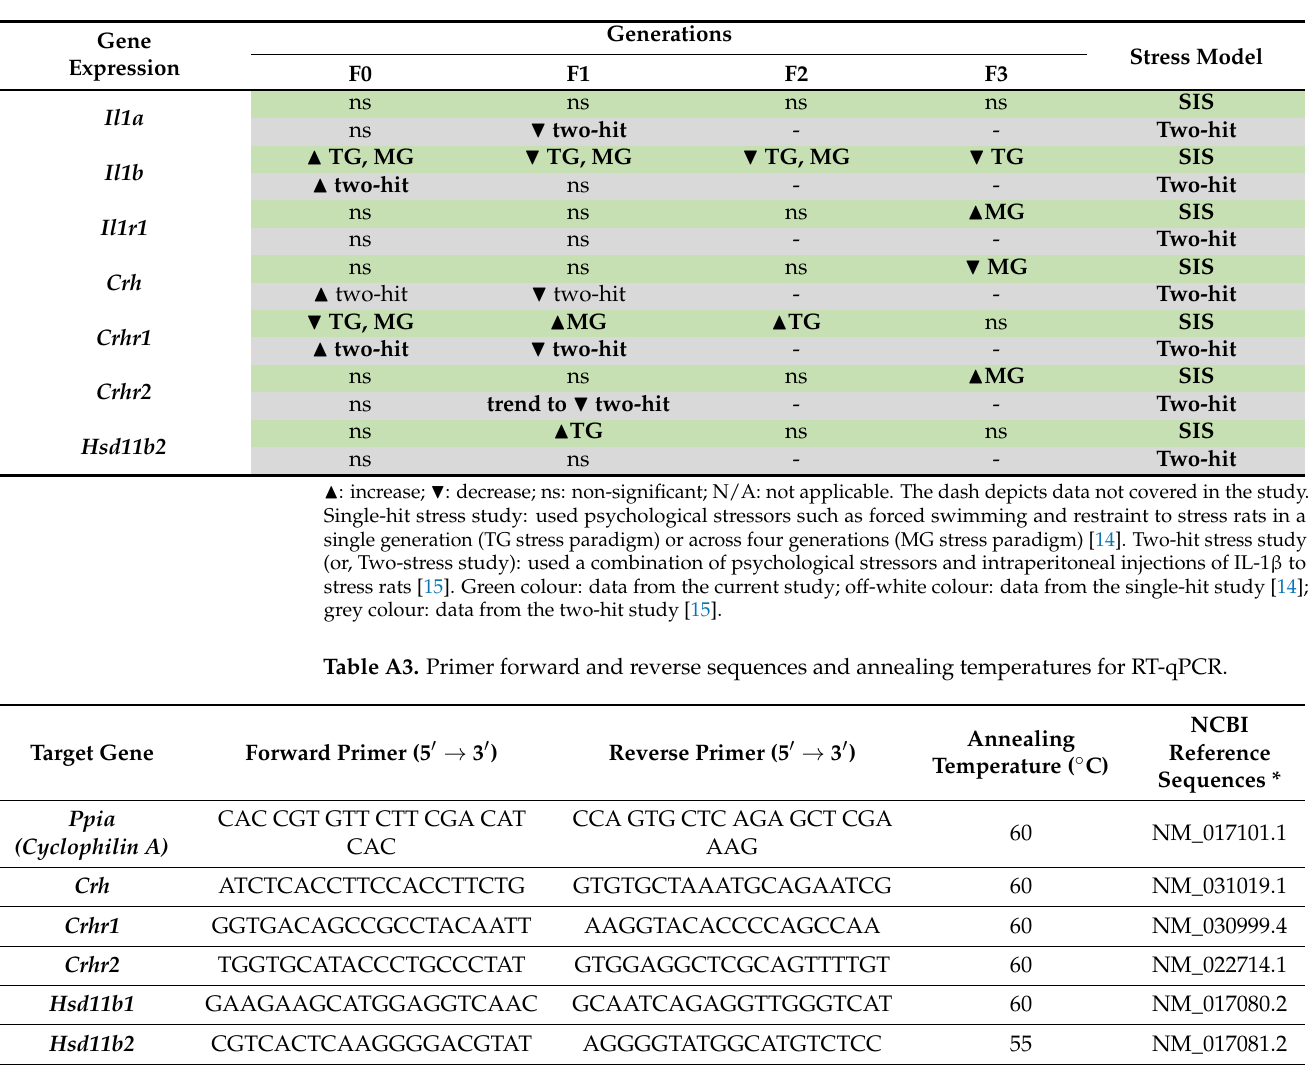
Table A2. Uterine gene expression comparison between SIS and two-hit stress models [15]. Uterine gene expression was not measured in the one-hit stress model of restraint and forced swimming [14].